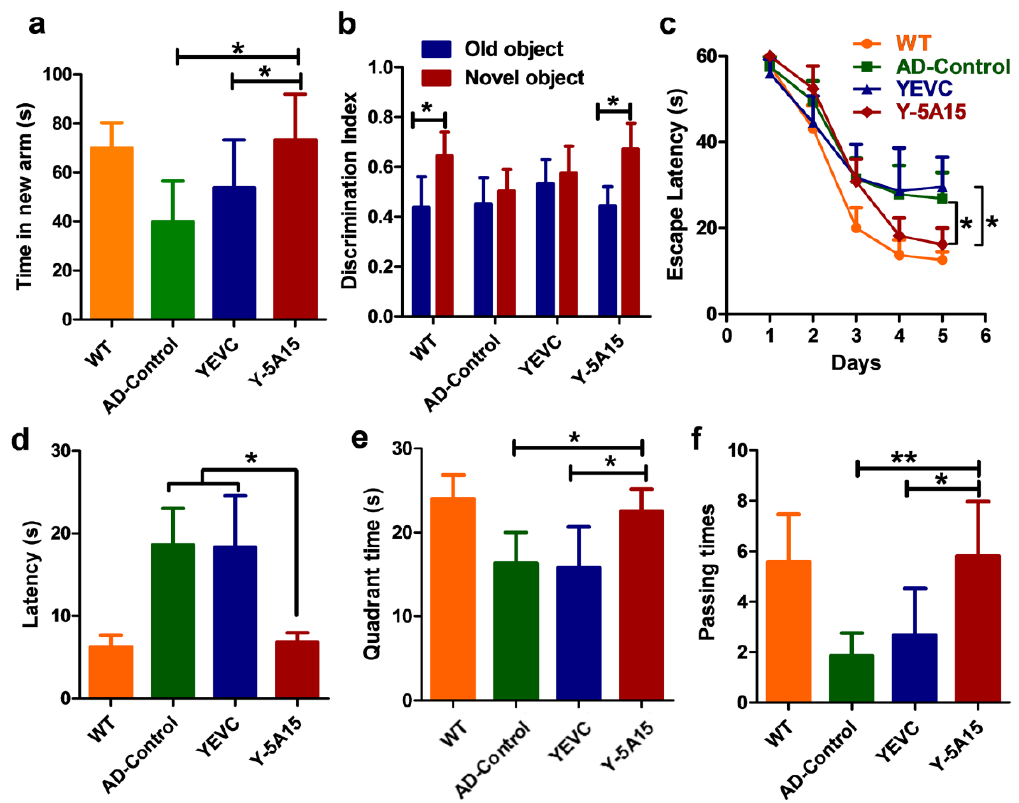
Figure 3. Y-5A15 vaccination improved cognitive capacity in APP / PS1 transgenic mice. ( a ) In the Y-maze, the time spent by mice in the new arm. ( b ) Discrimination index of AD mice tested by novel object recognition (NOR). ( c ) The escape latency in the acquisition period of the Morris water maze (MWM). ( d ) The escape latency in the probe trial of the MWM without the platform. ( e ) The target quadrant time in the MWM probe test. ( f ) The times of crossing the platform location in the MWM probe test. One-way ANOVA with LSD was used for statistical analysis. n = 6 mice per group, * p < 0.05, ** p < 0.01.